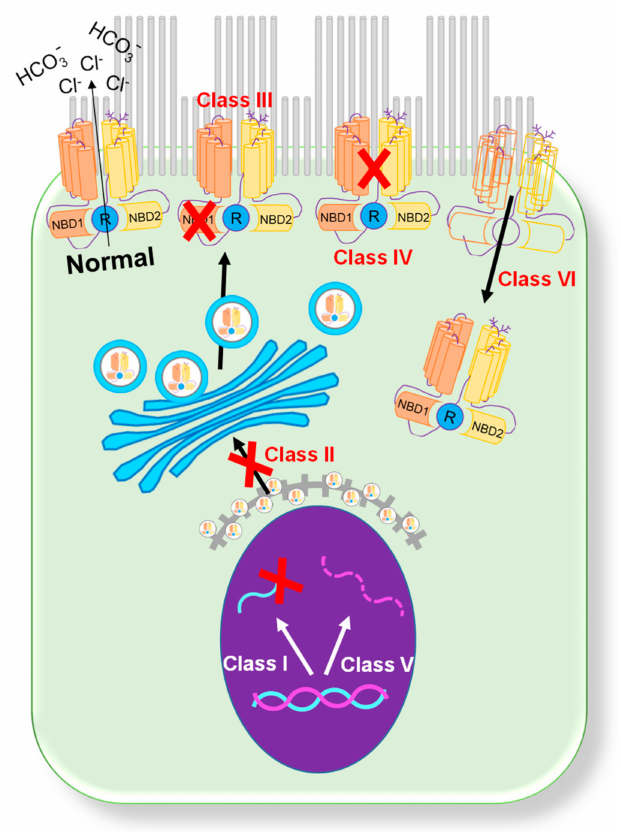
Figure 1. Classification of CFTR mutations. A schematic showing six categories of CFTR mutations [4]. CF animal models (e.g., mouse [11–13], ferret [14,15], pig [16], rat [17], monkey [18], and sheep [19,20]) have been generated to recapitulate human CF mutations, but it is challenging to reproduce human disease with animal models (e.g., CF mice have normal lung function) [21]. To develop a novel in vitro CF model that helps researchers reproduce human organ physiology to investigate patient-specific disease is